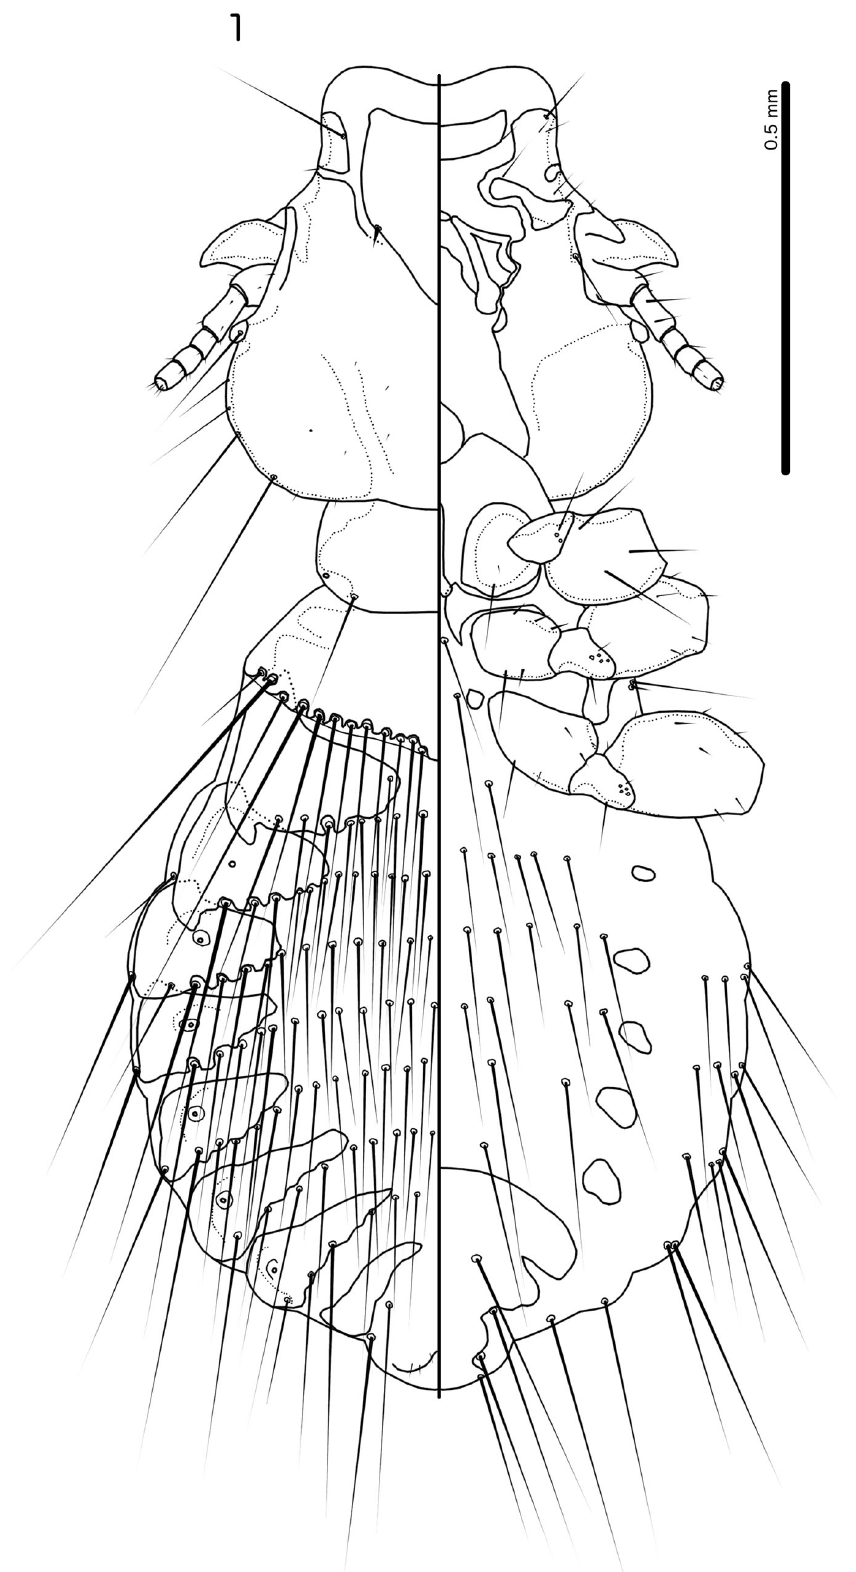
Fig. 1. Philopterus hebes sp. nov. ex Chloropsis aurifrons inornata Kloss, 1918, male habitus, dorsal and ventral